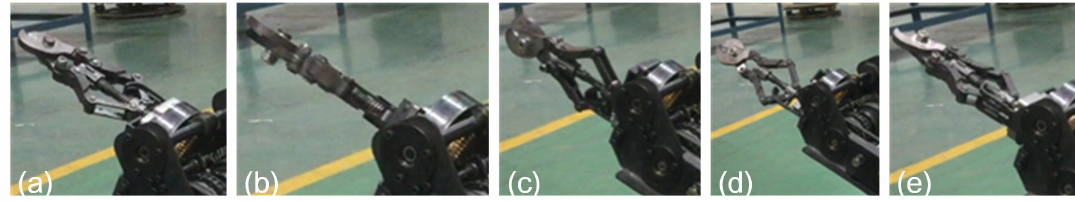
Figure 17. The rotating performance of the wrist joint assembly unit. ( a – e ) show the process of the scissors rotating 360 ◦ counterclockwise, which is driven by the wrist